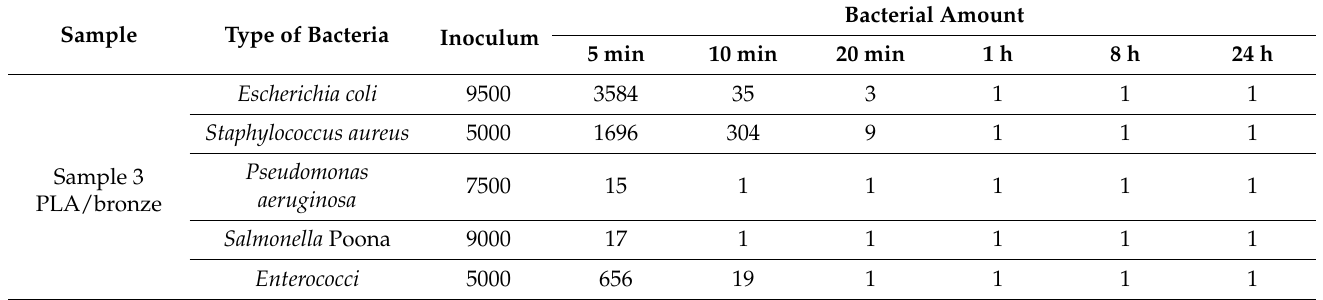
Table 4. Bacterial count on PLA/bronze sheet over different time intervals.